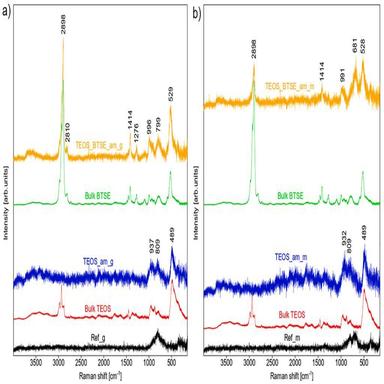
Raman spectra of layers deposited on a) glossy and b) mat sides with reference to bulk gels.